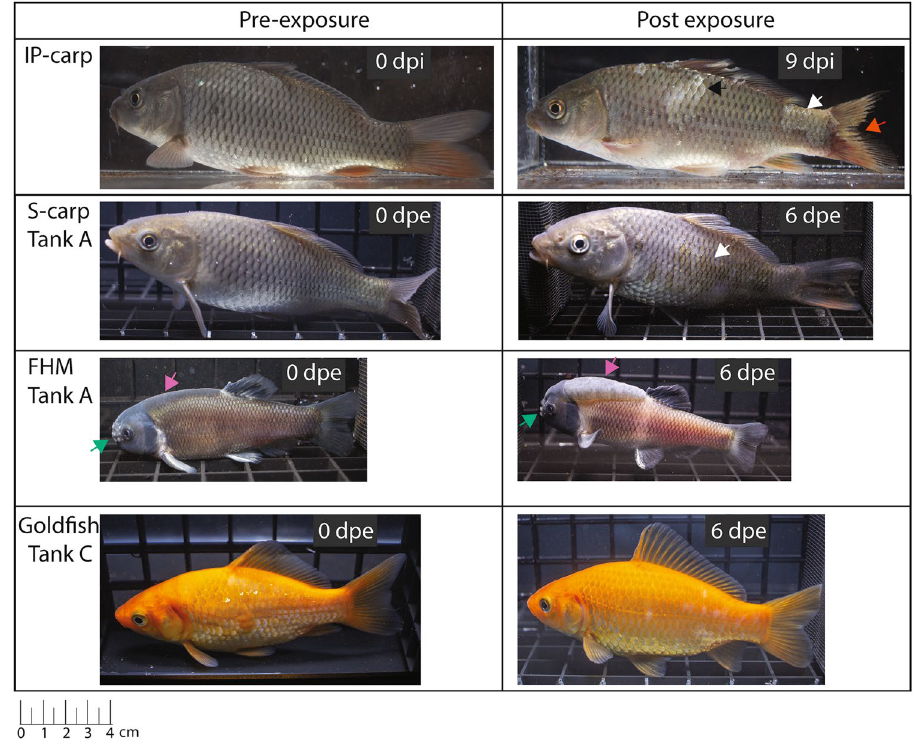
Figure 3. Representative fishes photographed before and after exposure to CyHV-3. Note, fishes photographed at 0 dpe may not be the same individual as those at 6 dpe. dpe days post exposure via cohabitation, IP-carp intraperitoneally injected carp, S-carp cohabitated sentinel carp, FHM fathead minnow. Arrows denote frayed fins (vermillion), loss of mucosal layer (white), scale pocket edema (black). Additionally, normal morphological features of mature male fathead minnows are indicated for nuptial tubercles (bluish green), and nape pads varying in prominence (reddish